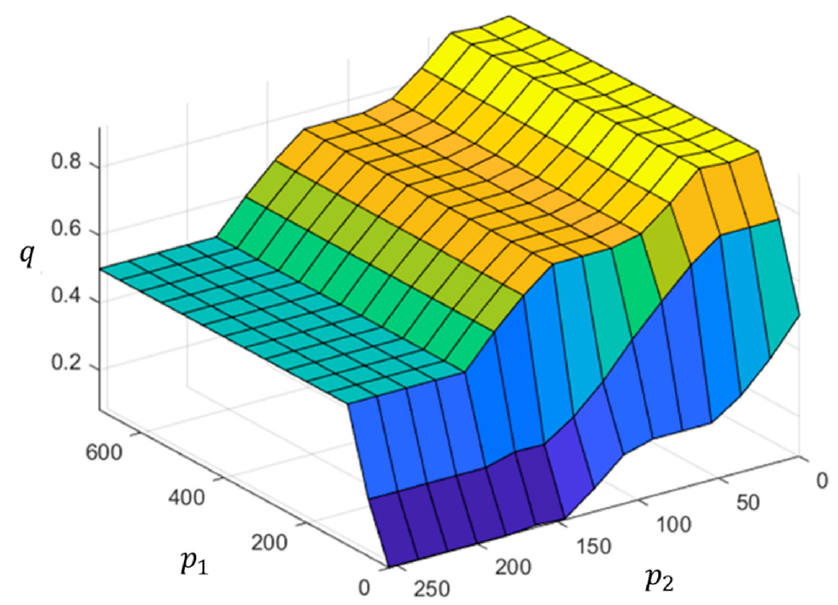
Figure 18. Input–output mapping surface of the proposed FIS.